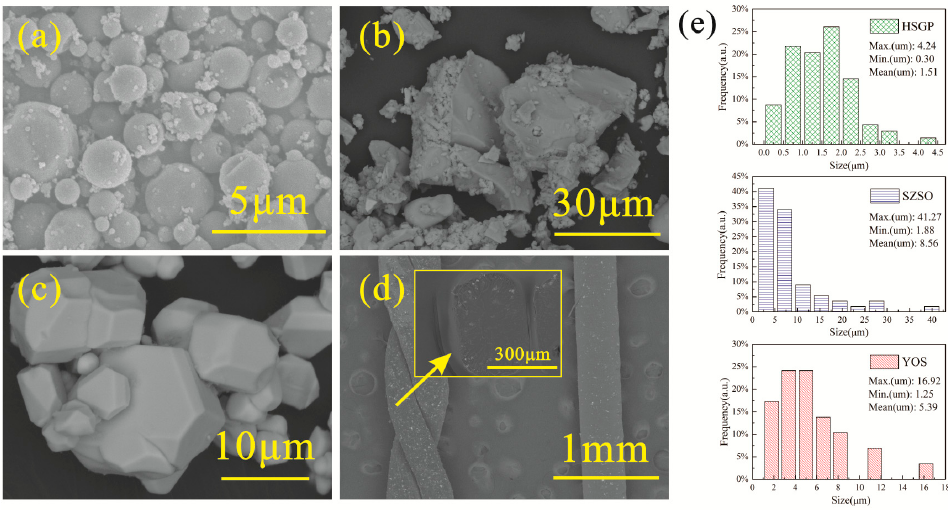
Figure 2. SEM images of ( a ) HSGP; ( b ) SZSO; ( c ) YOS; and ( d ) HSLF5. The inset image in ( d ) is the cross section of HSLF5; ( e ) Particle size distributions of HSGP, YOS, and SZSO.